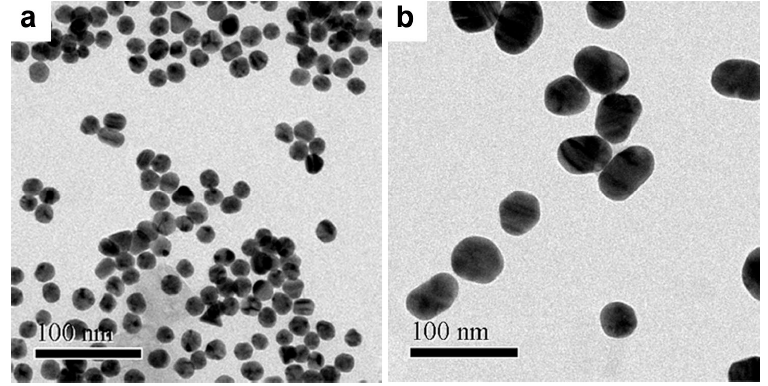
Figure 2. TEM images of ( a ) 20 nm and ( b ) 50 nm GNPs.